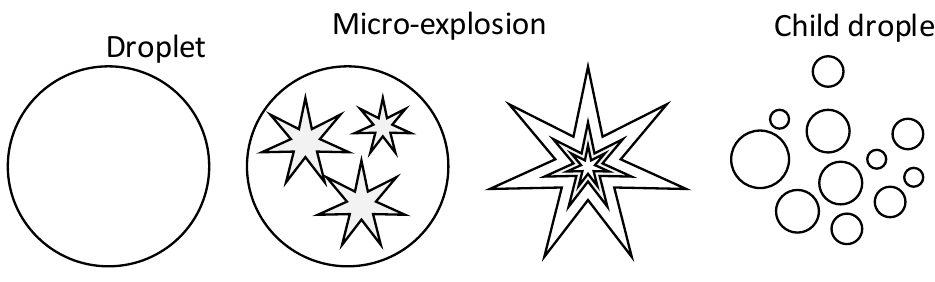
Figure 9. Scheme of micro-explosive breakup.